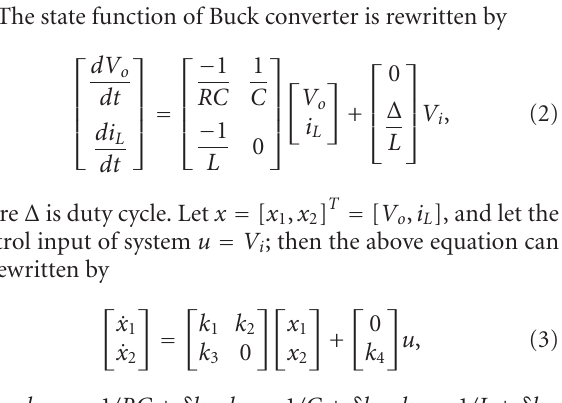
Figure 2: Buck converter